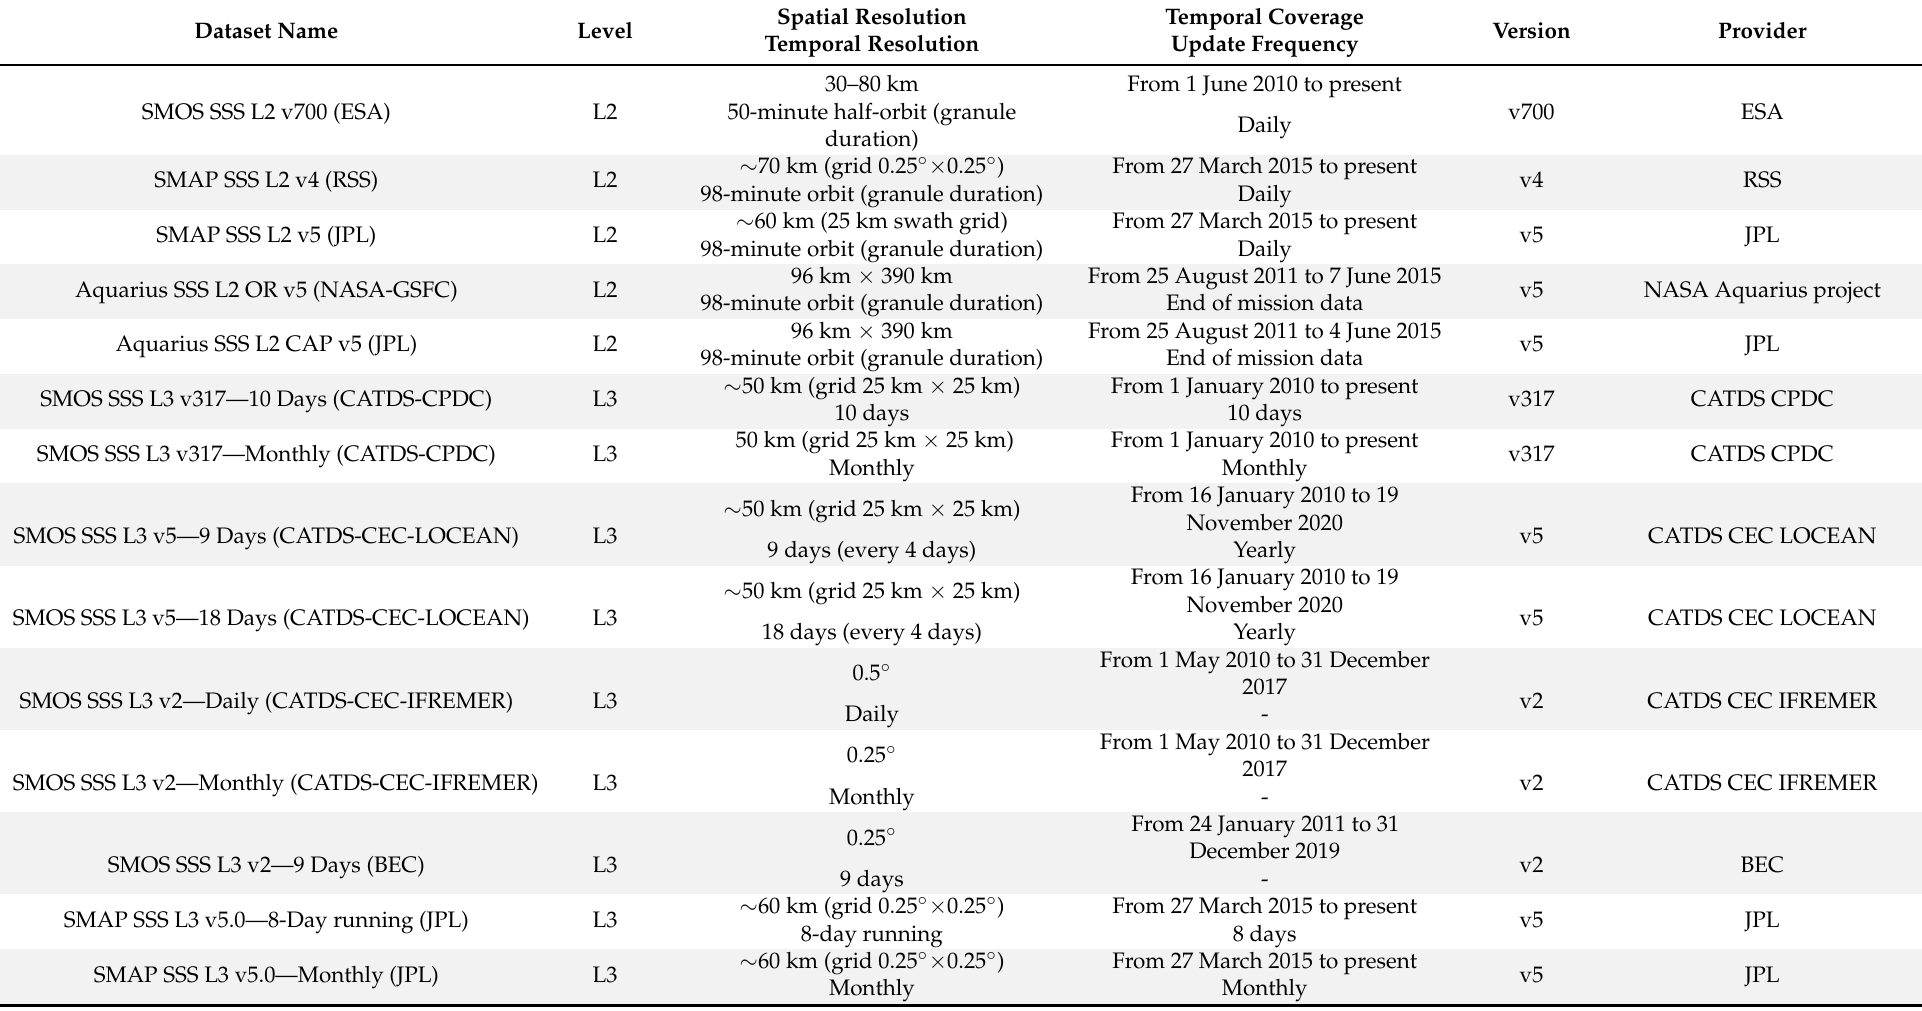
Table 2. List of Satellite SSS products available in Pi-MEP (15 September